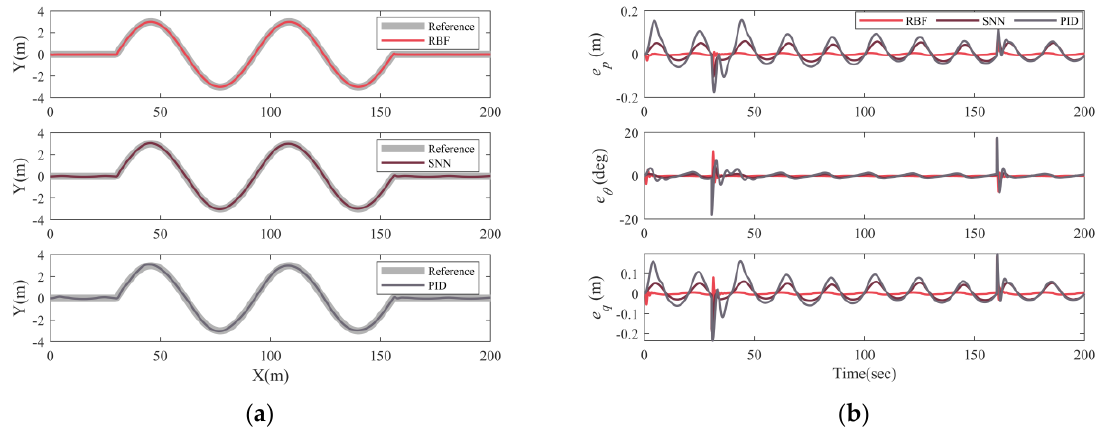
Figure 9. Comparison of results of different control algorithms in tracking a snaking path: ( a ) trajectory and ( b ) tracking errors.